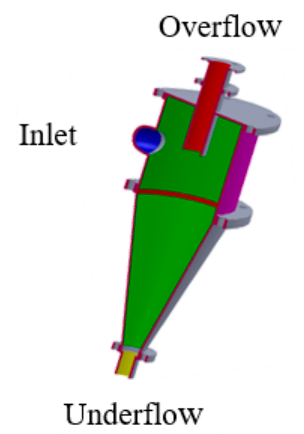
Figure 1. Traditional cyclone with two products. Figure1. Traditional cyclone with two products. Figure1. Traditional cyclone with two products. Figure1. Traditional cyclone with two products.